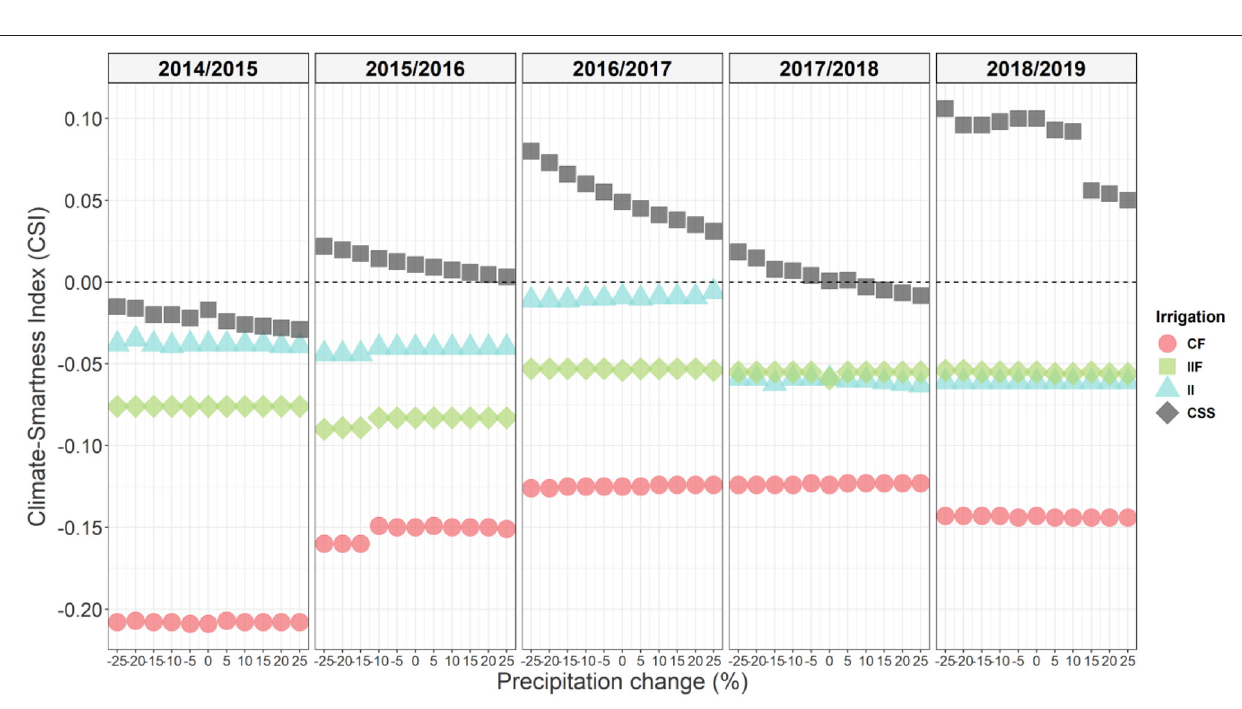
Frontiers in Sustainable Food Systems |